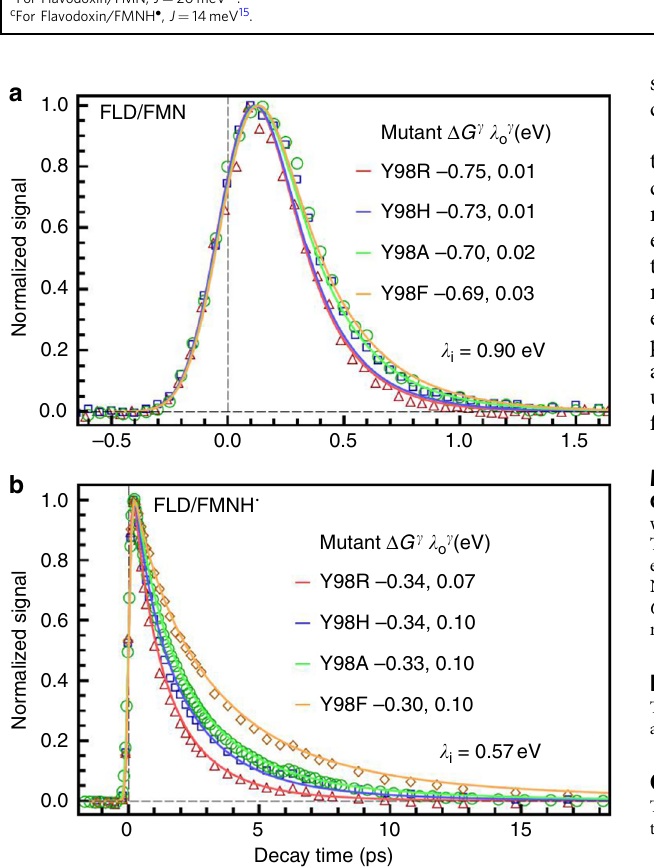
Fig. 5 Simulations of experimental ET dynamics in fl avodoxin. Simulations (solid lines) for different mutants are compared with experimental results (symbols). All time constants are in the unit of ps. a The ET reaction in fl avodoxin/FMN (oxidized state) with S ( t ) = 0.53 e − t /1.0 + 0.26 e − t /25 + 0.21 e − t /670 . b The ET reaction in fl avodoxin/FMNH (cid:129) (semiquinone) with S ( t ) = 0.76 e − t /2.6 + 0.24 e − t /40